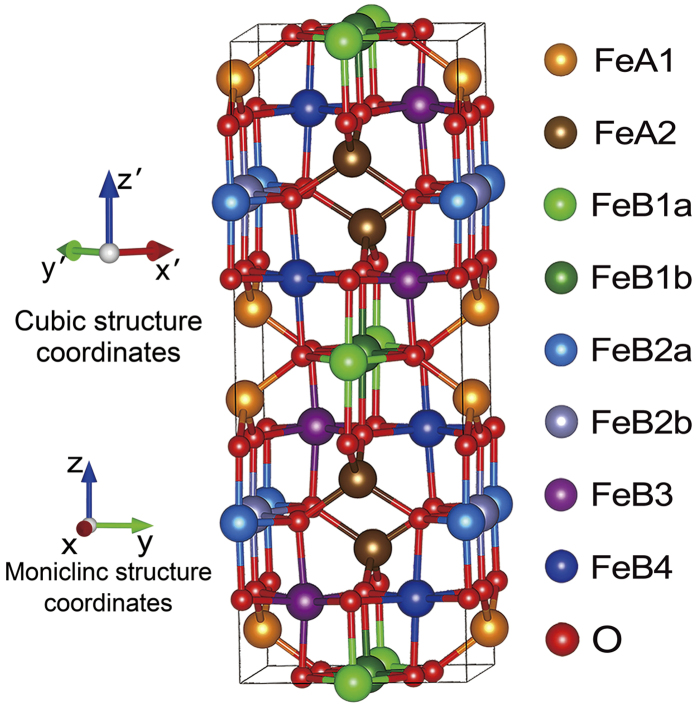
The lattice structure of Fe3O4 with P2/c symmetry.The equivalent atom sites of Fe ions have the same color. The monoclinic coordinate is rotated from cubic coordinate around z axis by 135°.